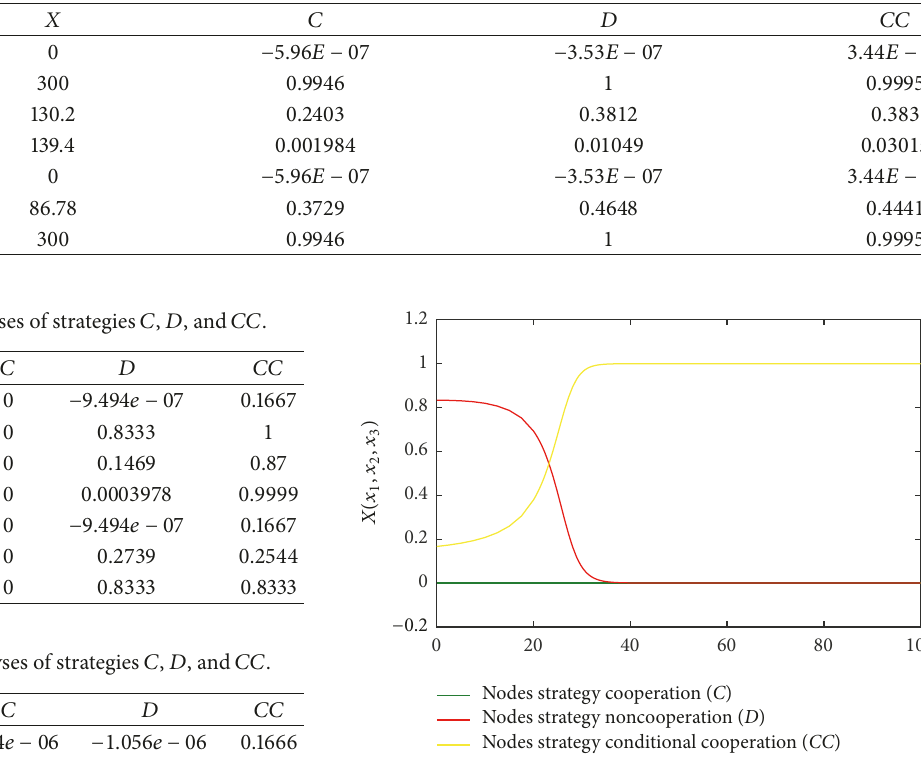
Table 8: The statistical analyses of strategies 𝐶 , 𝐷 , and 𝐶𝐶 .